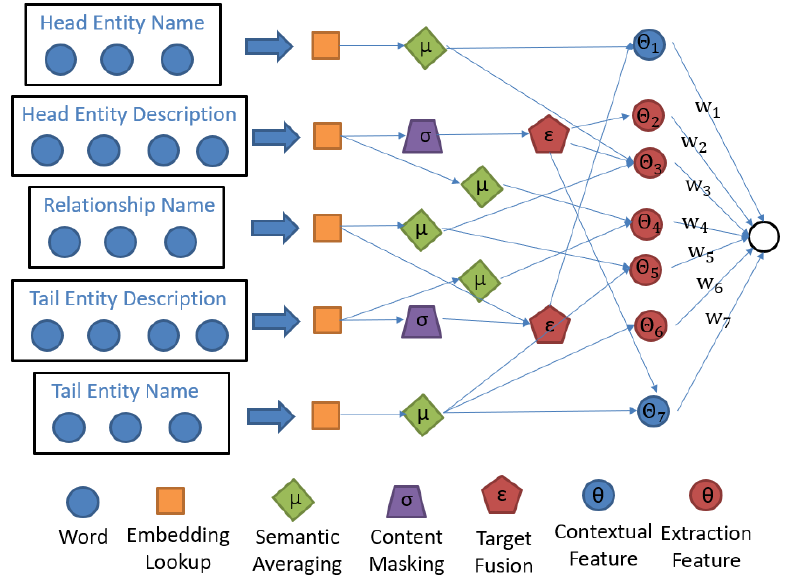
Figure 11. Illustration of the ConMask model for open-world knowledge graph